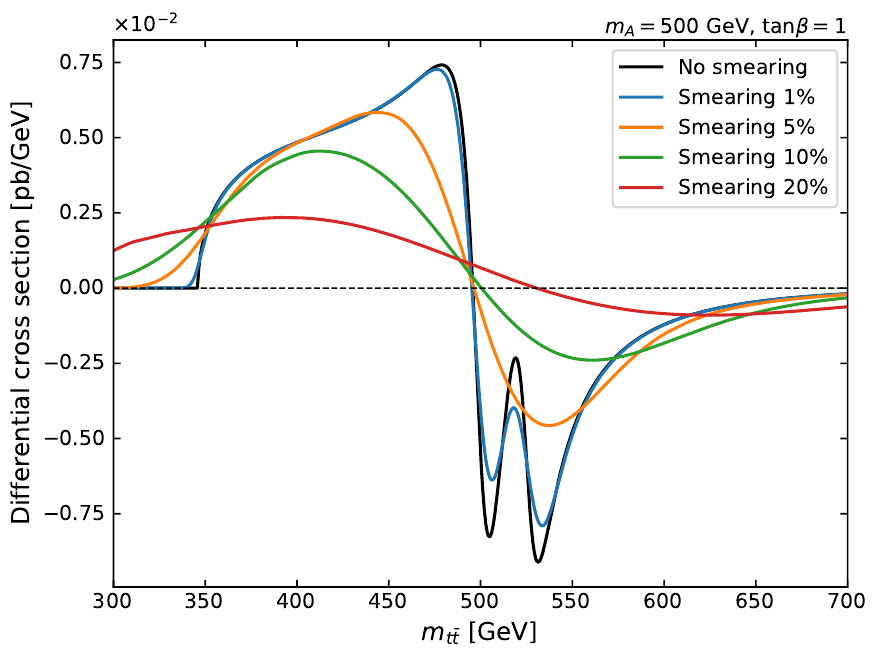
Figure 8 . The full BSM contribution to the m tan (cid:12) = 1, as obtained for di(cid:11)erent values of the m